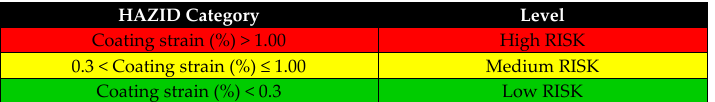
Table 1. Maximum permissible stress according to members.